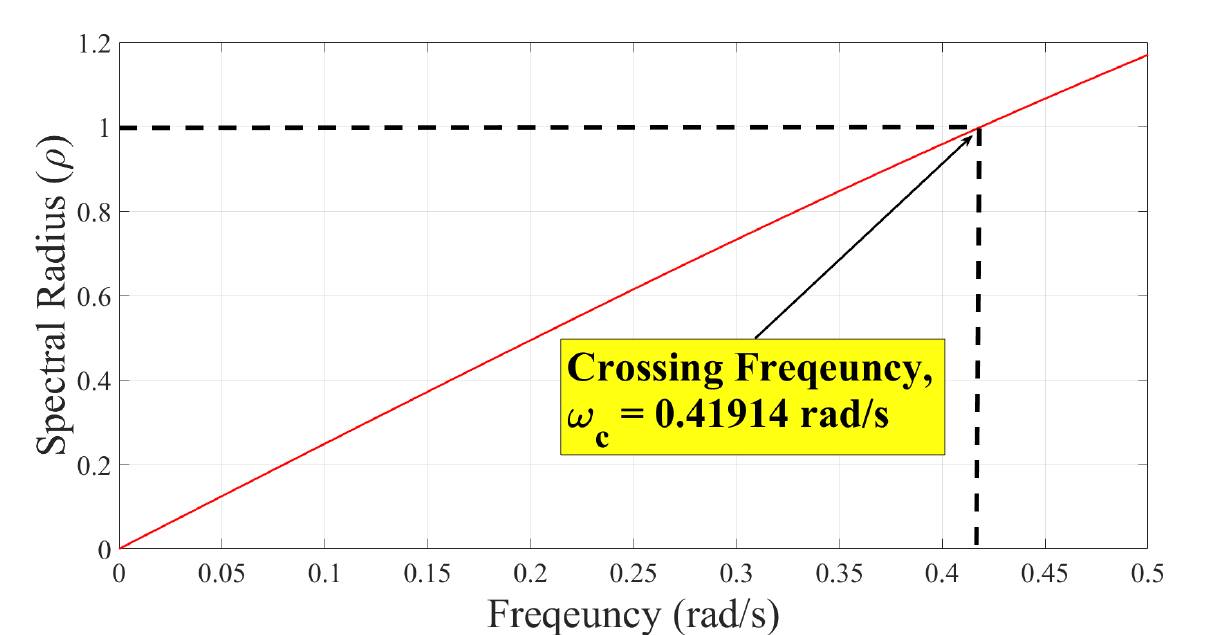
Figure 12. The spectral radius, ρ , against the frequency, ω , for K P = 0.2 and K I =